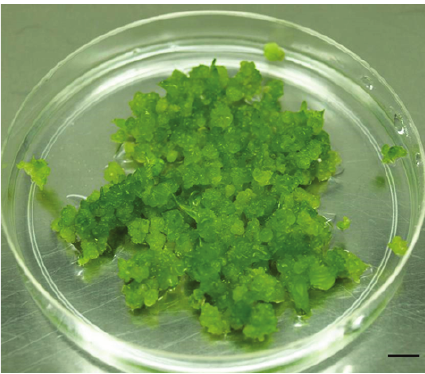
Figure 1: In vitro culture of VKD’s PLBs. Bar represent